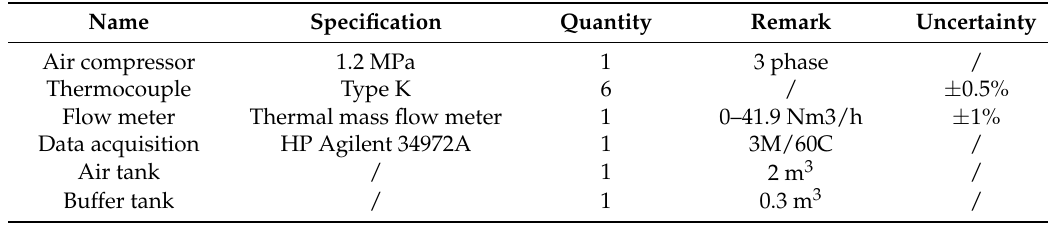
Table 1. The performance of the